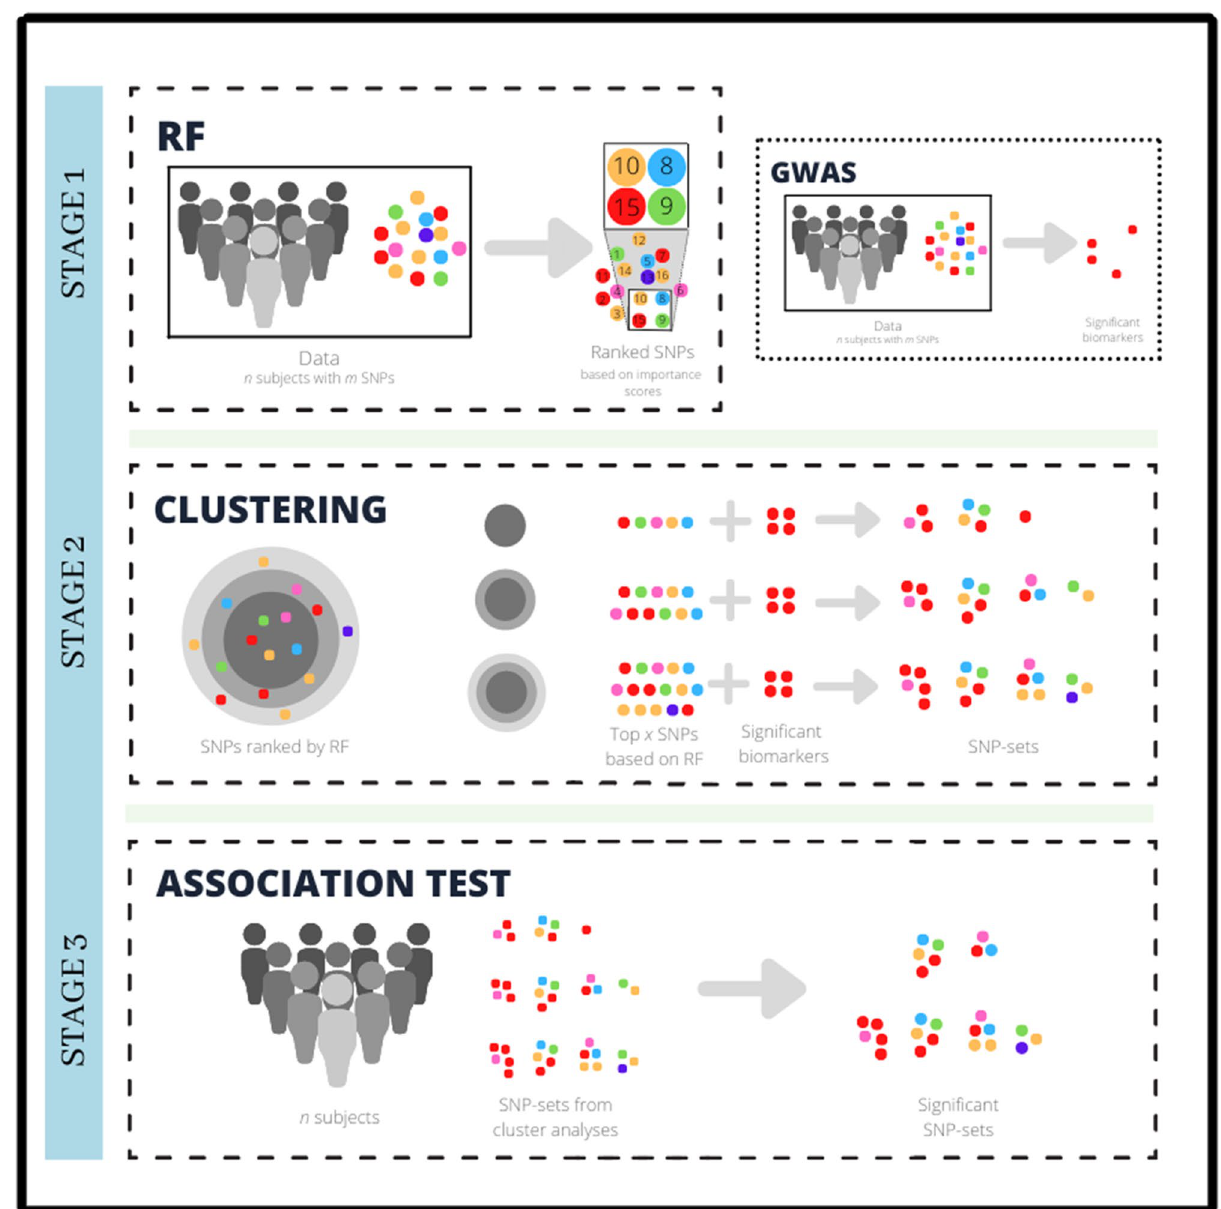
Figure 1. The architecture of the proposed integrated framework. In Stage 2, SNPs in concentric circles in darker shades of gray represent higher-ranking SNPs based on RF. (Image generated using Canva 40